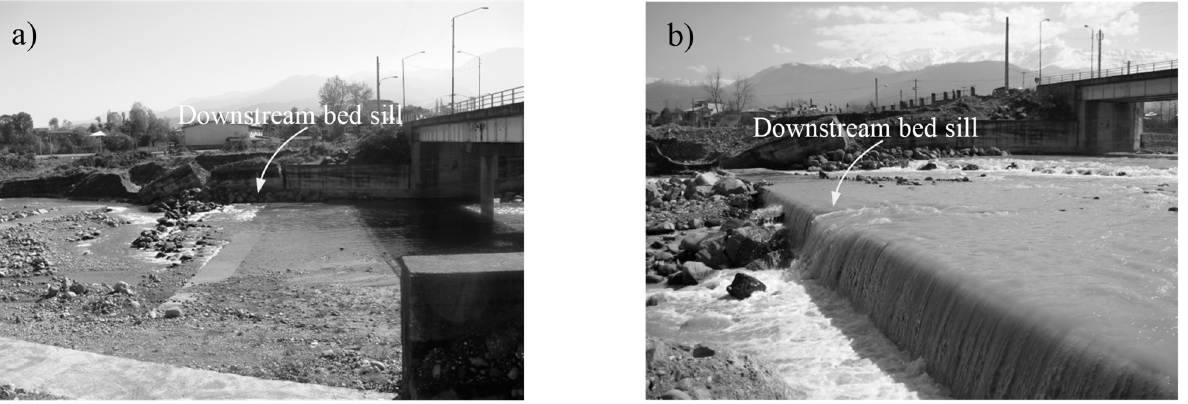
Figure 2. Effect of a bed sill on protecting the Machian bridge at a degrading reach of the Polroud river, Guilan province, Iran. Photographs taken in ( a ) 2010 and ( b ) 2011.